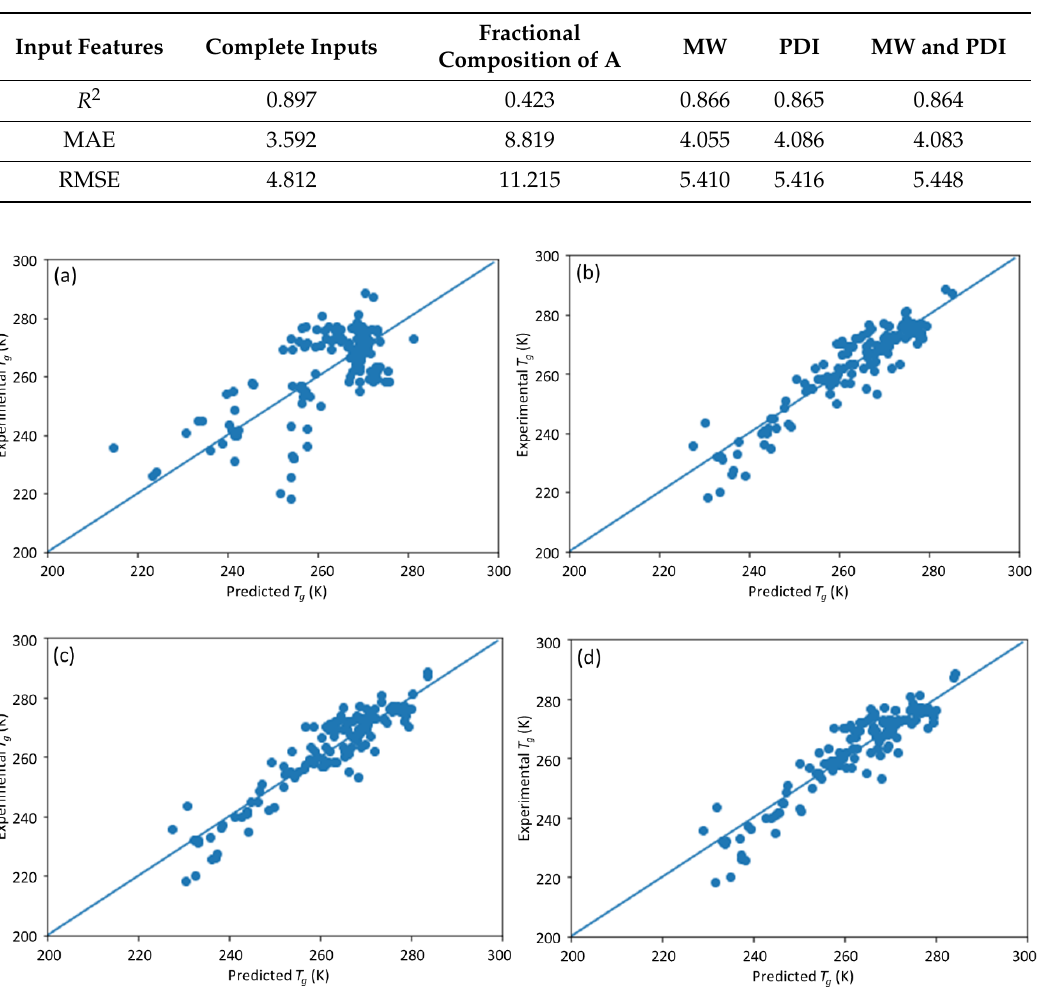
Figure 10 Figure 10. The scatter plot of the DNN model predicted vs. experimental T g with di factors estimated with the mean value. ( a ) Fractional composition of A; ( b ) molecular weight; ( c ) PDI; ( d ) molecular weight and